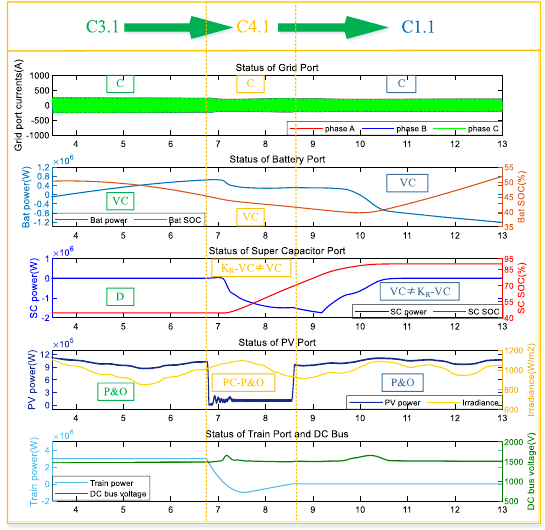
Fig. 15 Simulation waveform diagram of each port of typical working condition switching under train deceleration